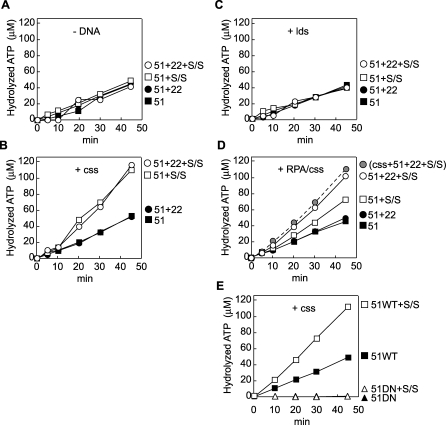
Effect of Mediators on the Rhp51 ATPase ActivitySwi5-Sfr1, but not Rad22, specifically activates the ssDNA-dependent ATPase activity of Rhp51. Proteins, ssDNA, or dsDNA, as indicated, were mixed in different combinations at the concentrations used in the standard strand exchange reaction.(A–D) Time courses of ATP hydrolysis are shown in the absence of (A) DNA or the presence of (B) ssDNA, (C) dsDNA, or (D) RPA-coated ssDNA. Note that the gray circles in (D) indicate a reaction containing all protein components in the presence of RPA-free css, used as a control, essentially the same as the open circles in (B).(E) The Walker B box mutant protein Rhp51D244N is defective in ATP hydrolysis, and Swi5-Sfr1 does not stimulate its ATPase activity. 22, Rad22; 51, Rhp51; S/S, Swi5-Sfr1.